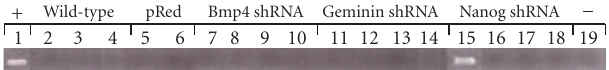
Figure 5: Oas1 PCR. Single embryo RT reactions were subjected to 40 cycles of PCR with primers for Oas1 mRNA (71). Mouse brain RT was used as a low-level expression positive control (+). Only 2 nanog shRNA embryos were positive for Oas1 expression (one shown, lane15). − = no cDNA